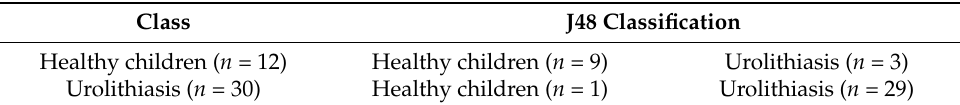
Table 4. The performance measures for classification tree (confusion matrix).